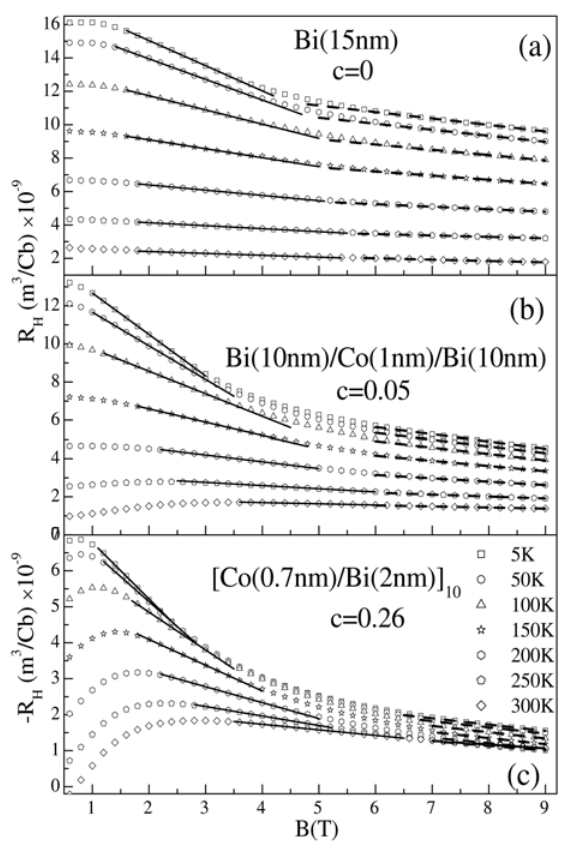
Fig.1. Hall coefficient R H vs B curves between 5K and 300K. Solid and dashed lines are linear fits.